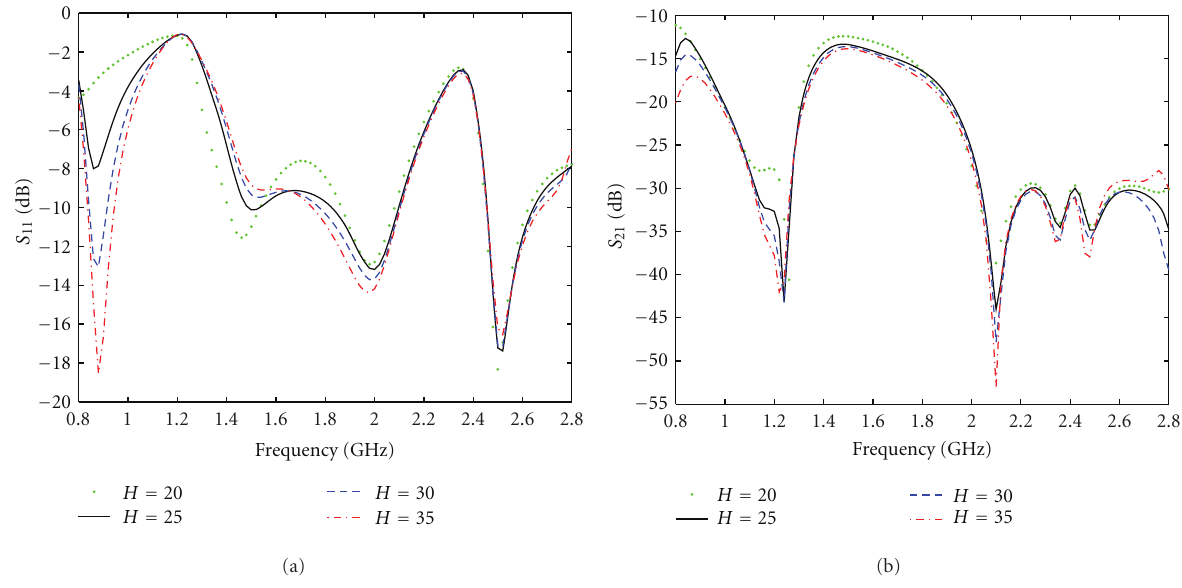
Figure 14: Simulated results of S parameters when parameter H varied (Unit: mm). (a) S 11 . (b) S 21 .